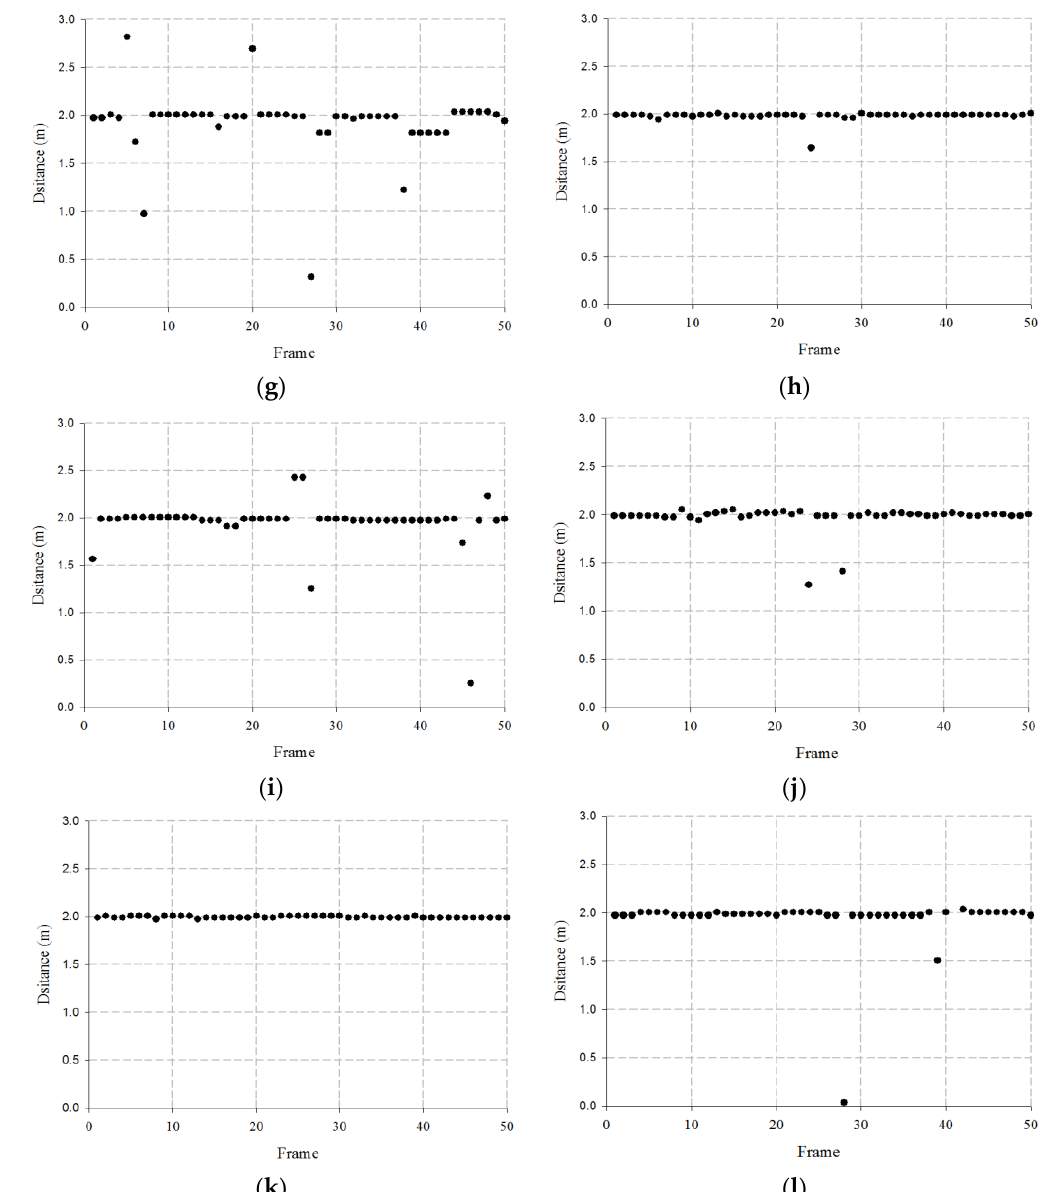
Figure 29. Measured results of single target using proposed beamforming antenna: ( a ) P2, ( b ) P3, ( c ) P4, ( d ) P4, ( e ) P5, ( f ) P6, ( g ) P6, ( h ) P7, ( i ) P8, ( j ) P8, ( k ) P9, and ( l ) P10.